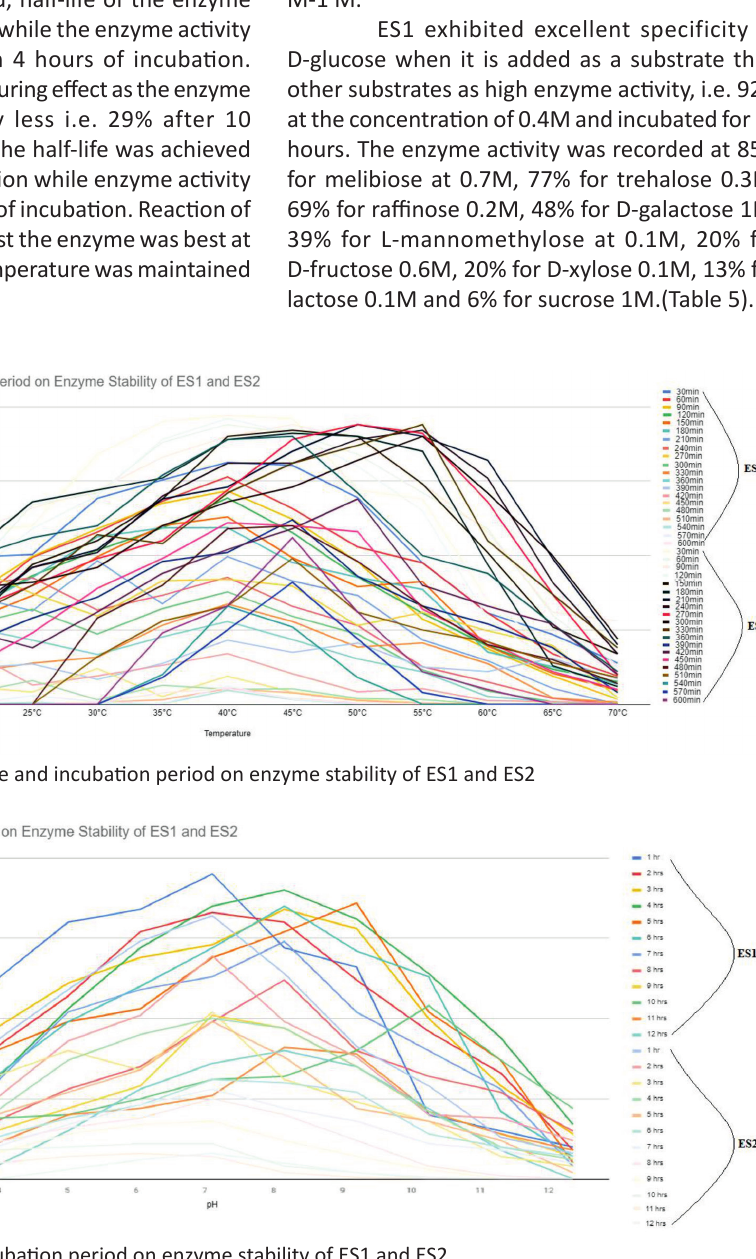
Fig. 4 . Effect of pH and incubation period on enzyme stability of ES1 and